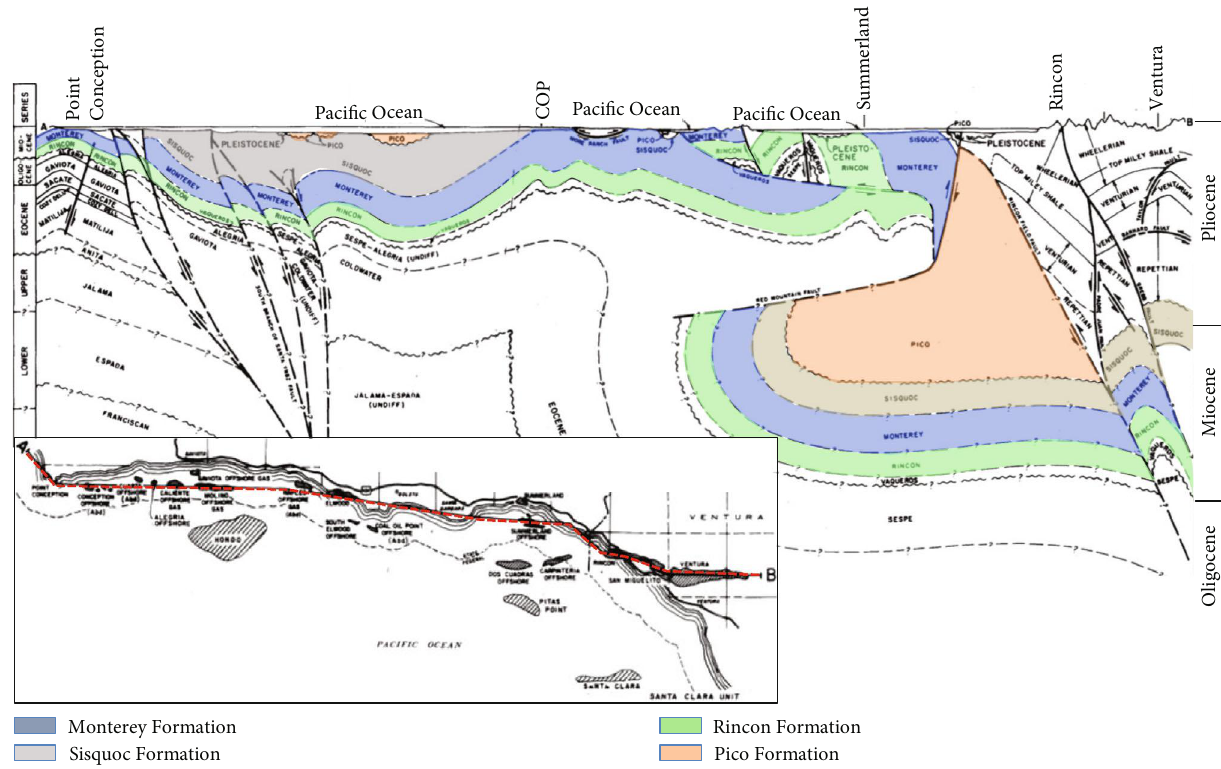
Figure 11: Generalized northern Santa Barbara Channel geological cross section from Point Conception to Ventura. Adapted from CDOG